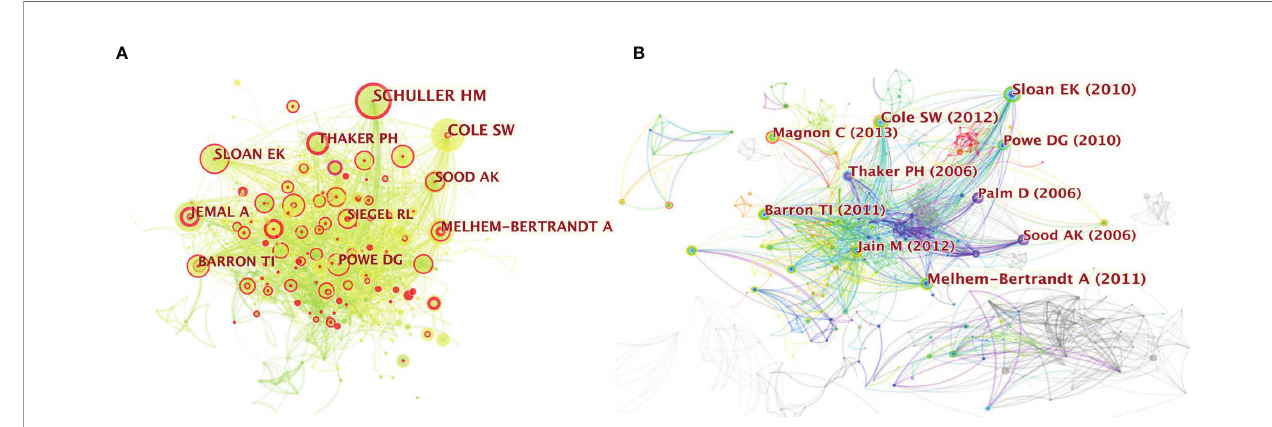
FIGURE 3 | (A) Citespace network of co-cited authorship in the fi eld of neurotransmitters and tumor progression research. Each circle represents one author. Size of circle is positively correlated with cited counts of the authors, and links between two circles represents a collaboration between two authors on the same article. Line thickness is positively correlated with frequency of collaborations. Top 10 most-cited authors are shown. Timespan: 2001-2021; Slice length=1; (B) Citespace co-citation map of 39677 references on neurotransmitters and tumor progression research, fi lter option showing the largest connected component only. Each circle represents a reference. Size of circle is positively correlated with frequency of citations, and links between two circles represent two references that were cited in the same article. Year and fi rst author of the top 10 most-cited publications are shown. Timespan: 2001-2021; Slice